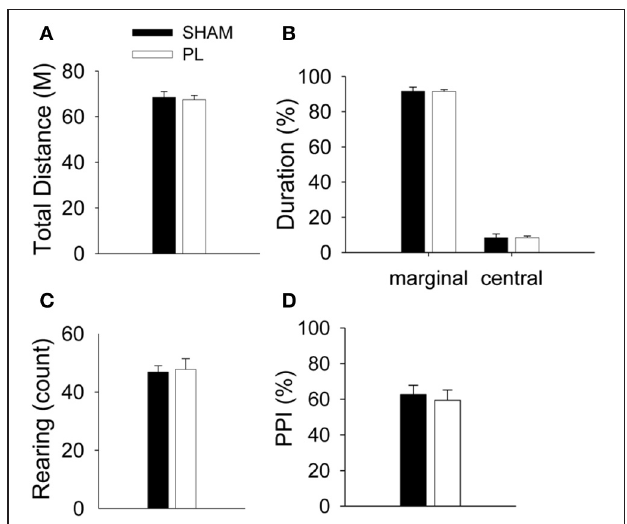
FIGURE A1 | Effects of PL lesions on general activity and sensory gating. There were no differences between groups in total distance (A) , the ratio of the duration in marginal and central area (B) , and rearing (C) . In the PPI test, the ratio of inhibition was not different between groups (D)